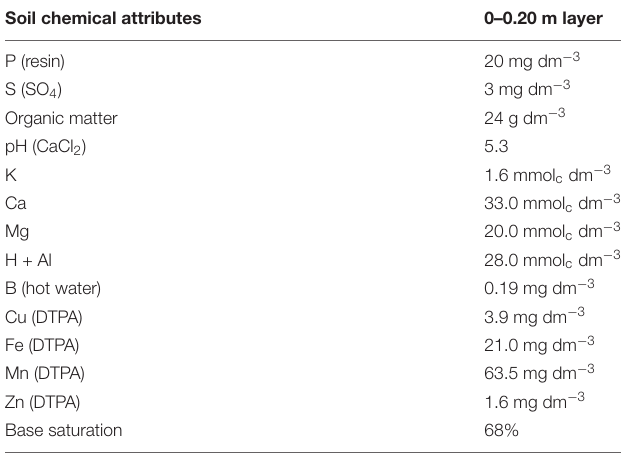
TABLE 1 | Soil chemical attributes in 0–0.20 m layer before field trial